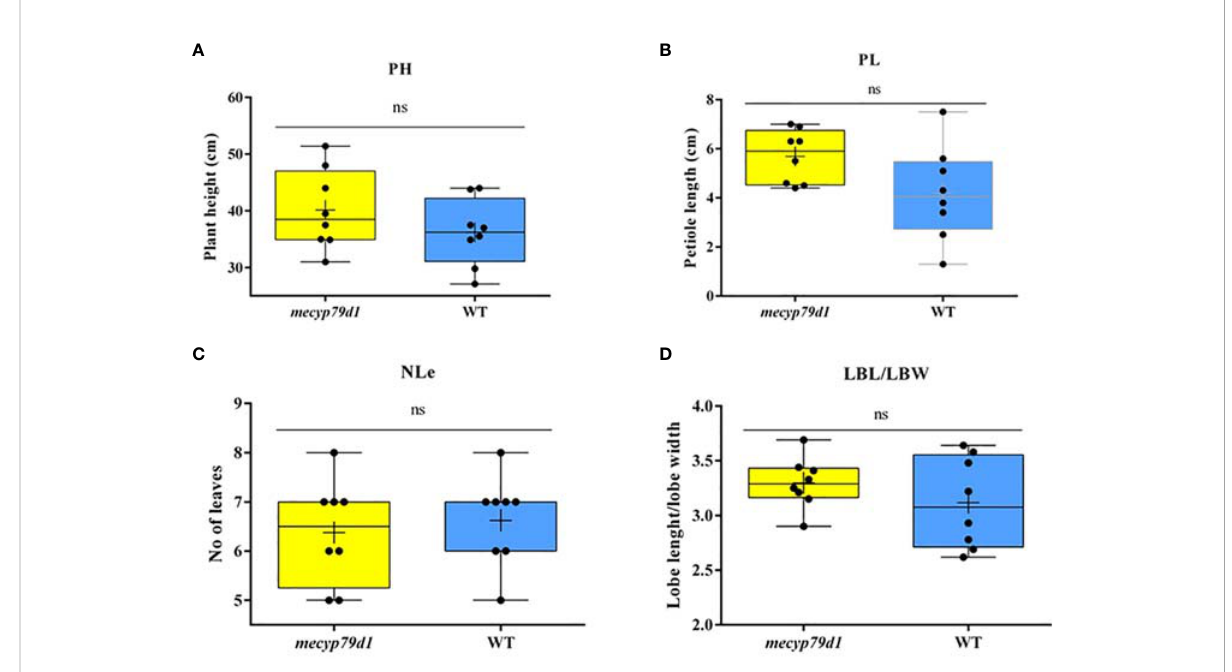
FIGURE 6 Phenotyping for agronomic traits of 4 month old mecyp79d and wild-type (WT) cassava plants. (A) Plant height; (B) Petiole length; (C) The number of leaves per plant; (D) The ratio between the leaf lobe length and the width. PH (plant height); petiole length (PL); NLe (number of leaves); LBL (lobe length); LBW (lobe width); ns (not signi fi cant). “ ns ” indicates the values are not signi fi cantly different